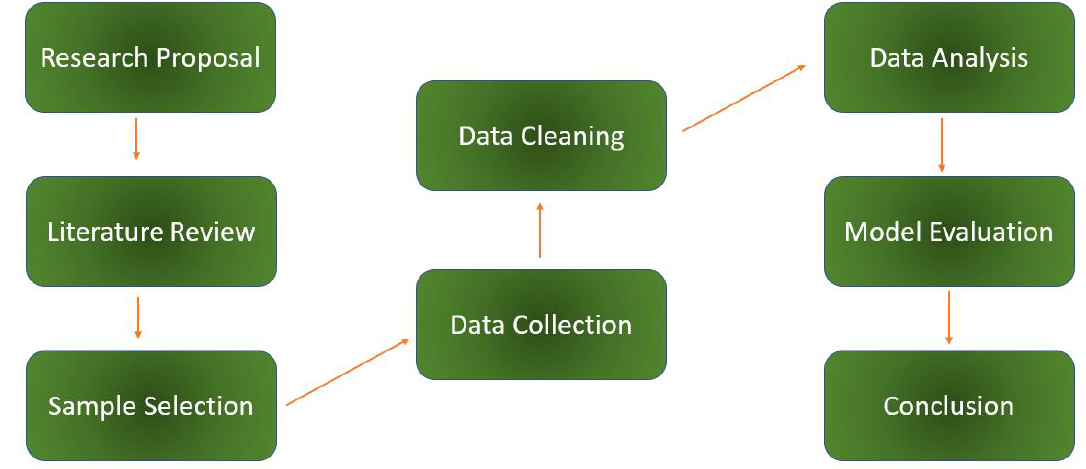
Figure 1. Flow chart of research methodology.